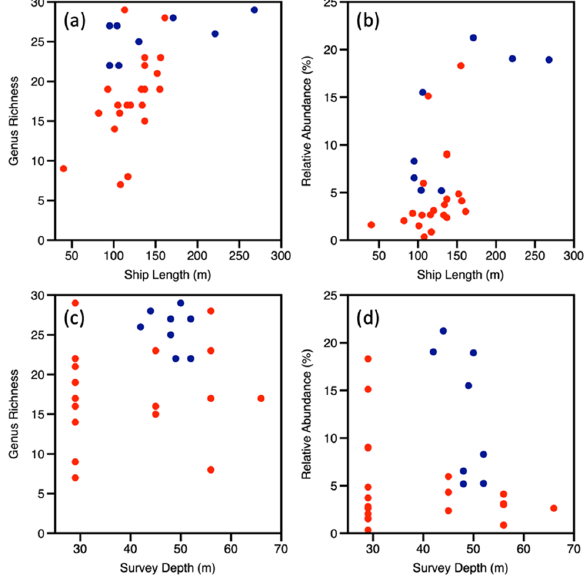
Figure 4. Relationships between the length and depth of sunken vessels and ( a , c ) coral genus richness and ( b , d ) relative abundance. Red and blue dots indicate ships in Chuuk and Bikini lagoons, respectively.